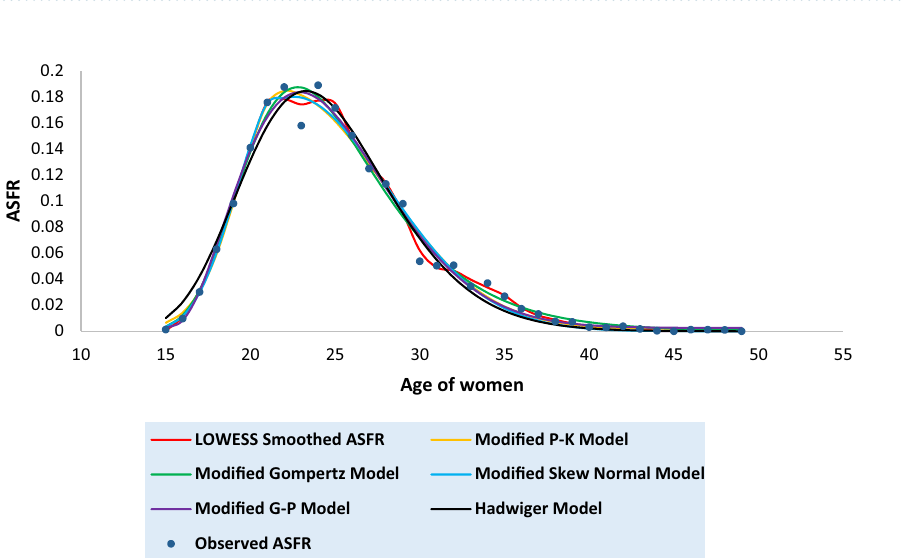
Figure 8. Observed and expected age-specific fertility rate (ASFR) for Gujarat under different proposed models and Hadwiger